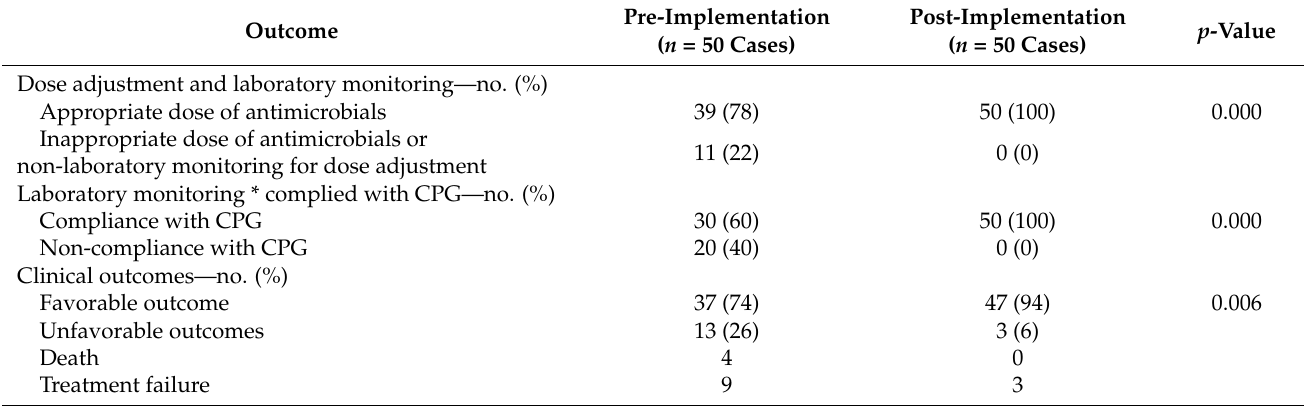
Table 2. Process and clinical outcomes of implementation in the pre-implementation and post- implementation